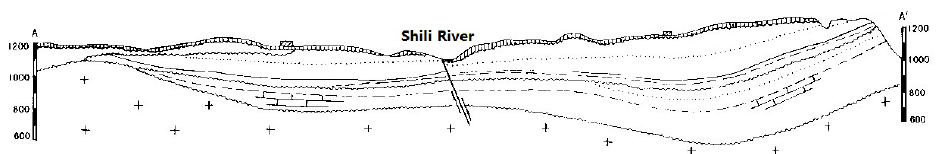
Figure 2. Schematic geological section of the subsoil in Guanyintang River basin.